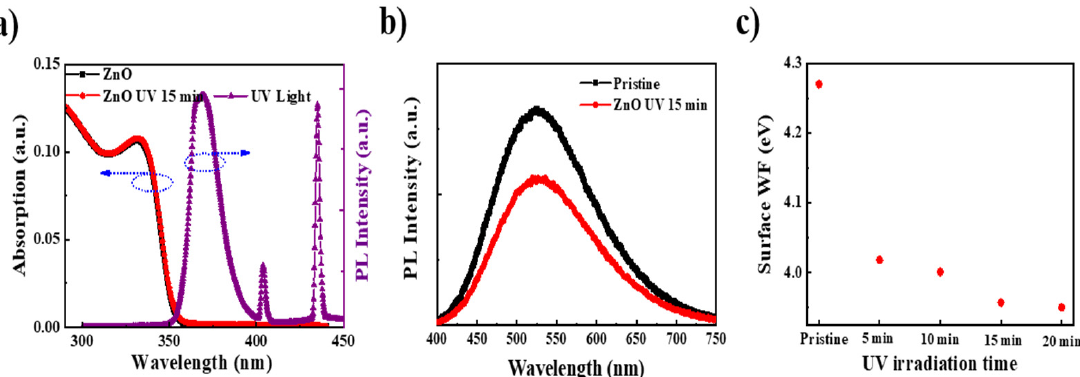
Figure 3. ( a ) Absorption of the ZnO film before and after 15 min of UV irradiation, and the emission spectrum of the UV curve machine; ( b ) PL spectra of the ZnO film before and after 15 min of UV irradiation in the UV–visible range excited by a 280 nm laser; ( c ) surface WF of the ZnO film on the ITO substrate with different UV irradiation times chartered by the SKP5050 system.